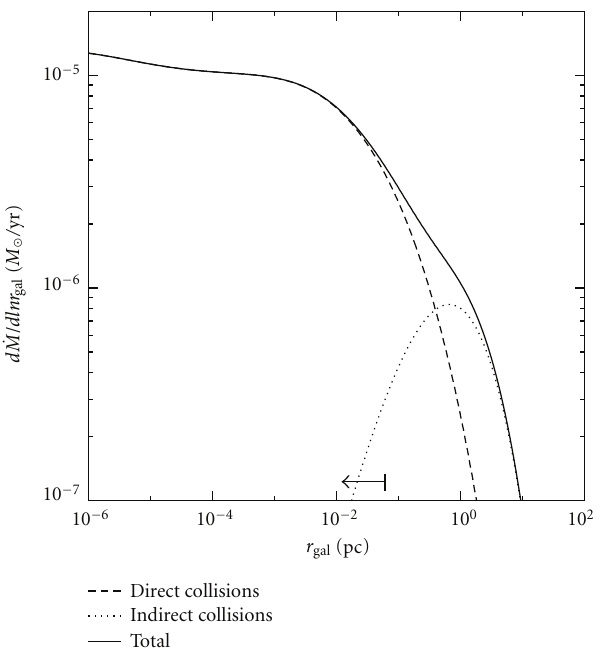
Figure 10: Mass loss rates due to direct and indirect stellar collisions within the Galactic center for M min = 0 . 2 M (cid:5) , M max = 100 M (cid:5) and α = 1 . 2. The arrow indicates the range in the di ff use X-ray observations ( r gal < 1 . 5 (cid:3)(cid:3) ) which we use to constrain the PDMF (see Section